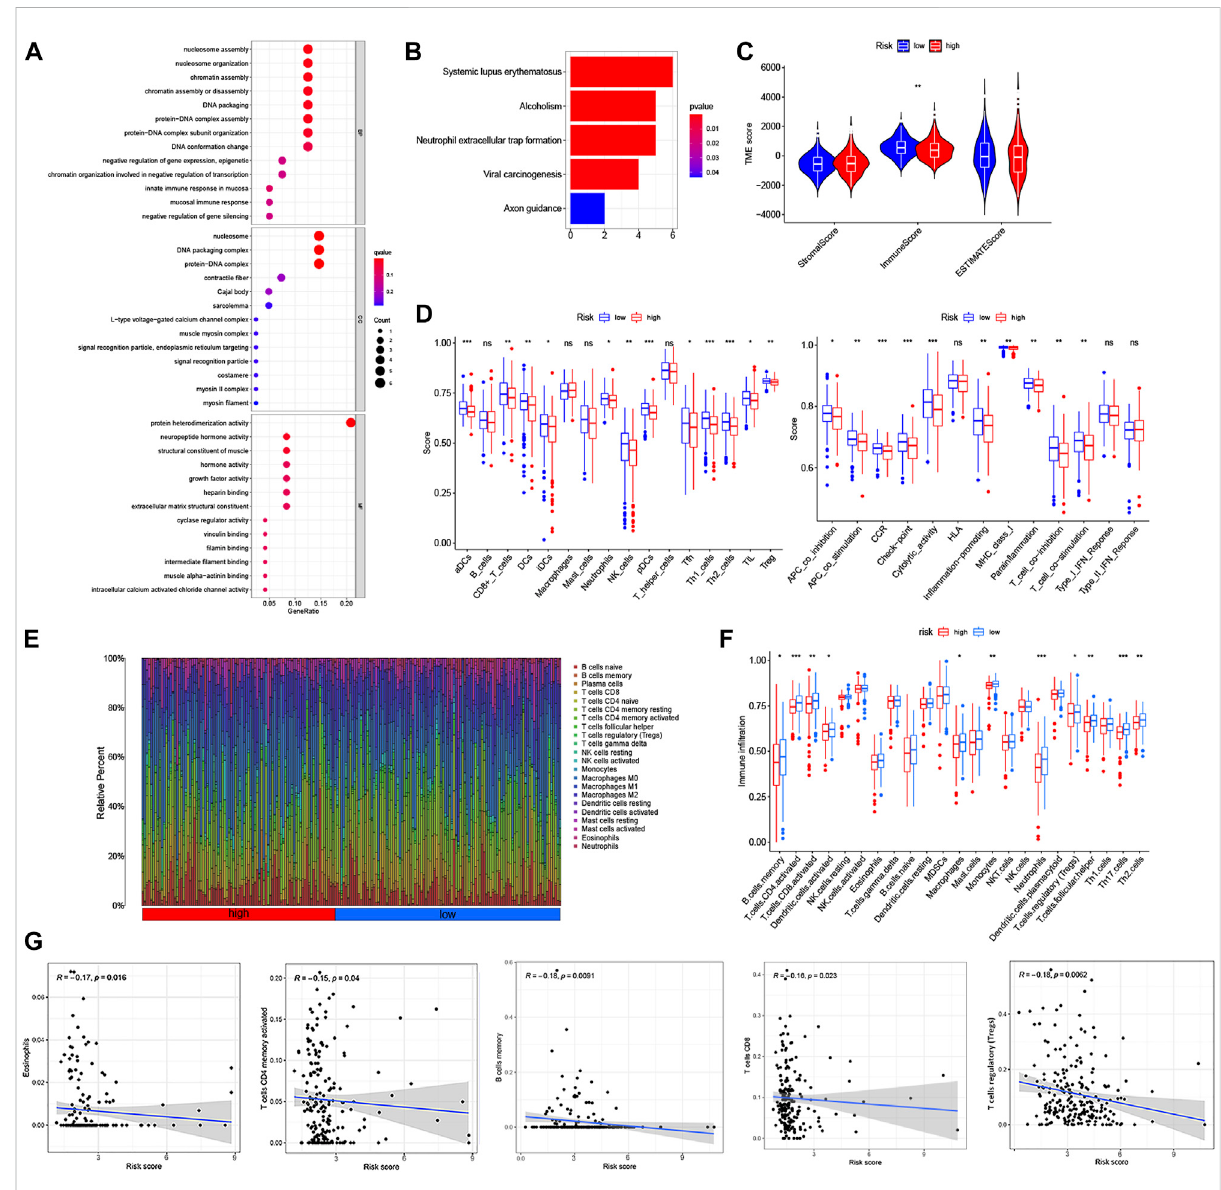
FIGURE 10 Functional enrichment analysis and comparison of the immune activity between high- and low-risk group based on the 8m6A-related lncRNA signatures. (A) The Bubble graph for gene ontology (GO) analysis. (B) The Barplot graph for Kyoto Encylopedia of Genes and Genomes (KEGG) analysis. (C) Correlations between the two-risk groups and TME score. (D) Comparison of the score of immune cells and immune-related pathways between the high-and low-risk group by ssGSEAScore. (E) Barplot showing the proportion of 22 kinds of tumor-in fi ltrating immune cells in CRC. Column names of plot were sample ID. (F) The differential in fi ltration levels of 22 kinds of immune cells between the two-risk groups based on the CIBERSORT platform. (G) The association of risk score with Eosinophil cells, B cells memory, CD8+T cells, CD4 memory-activated T cells and regulatory T (Treg) cells. * p < 0.05; ** p < 0.01; *** p <